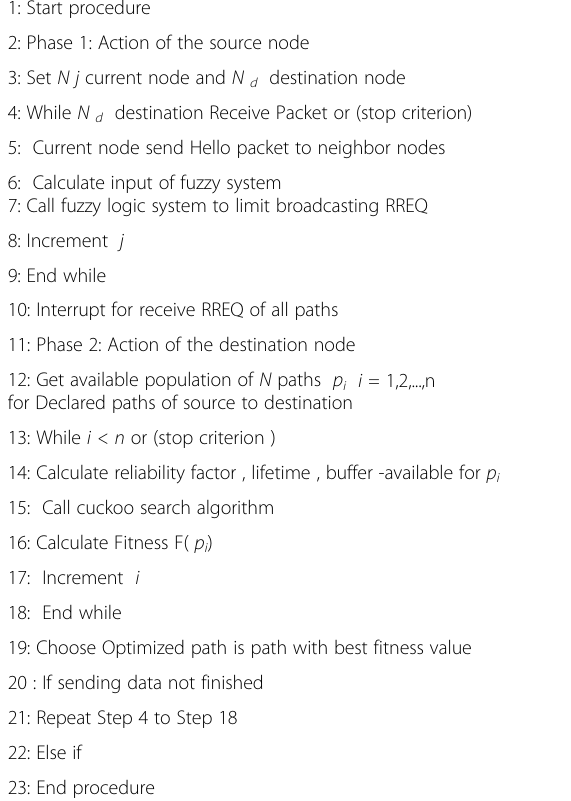
Table 2 Pseudo of TIHOO. The pseudo-code of the proposed protocol. The steps of the proposed protocol are shown in this figure in